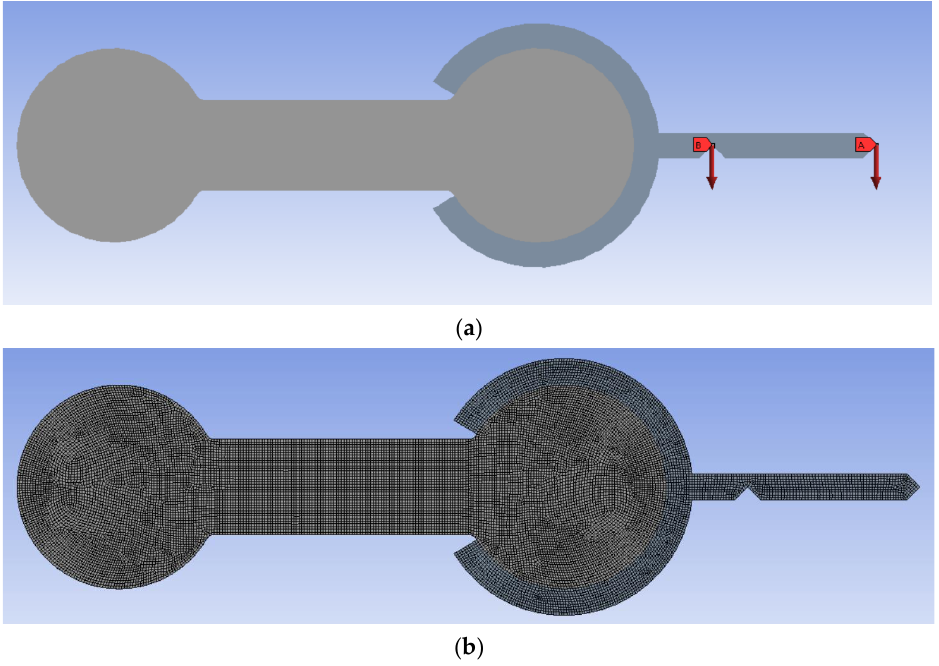
Figure 6. FEA model: ( a ) forces applied to the FEA model representing the weight of the bracket and the weights; ( b ) a typical mesh for an average element size of 0.10 mm.